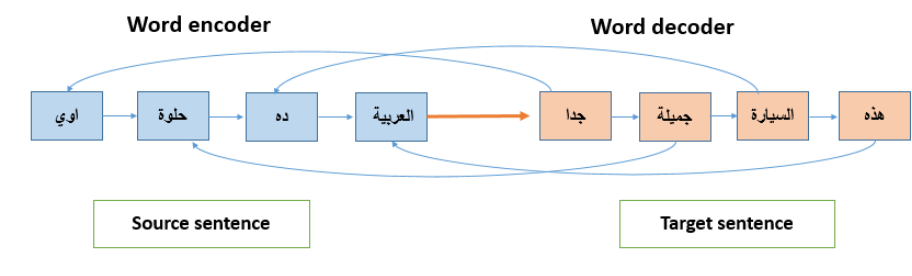
Figure 5. Seq2seq model for dialect